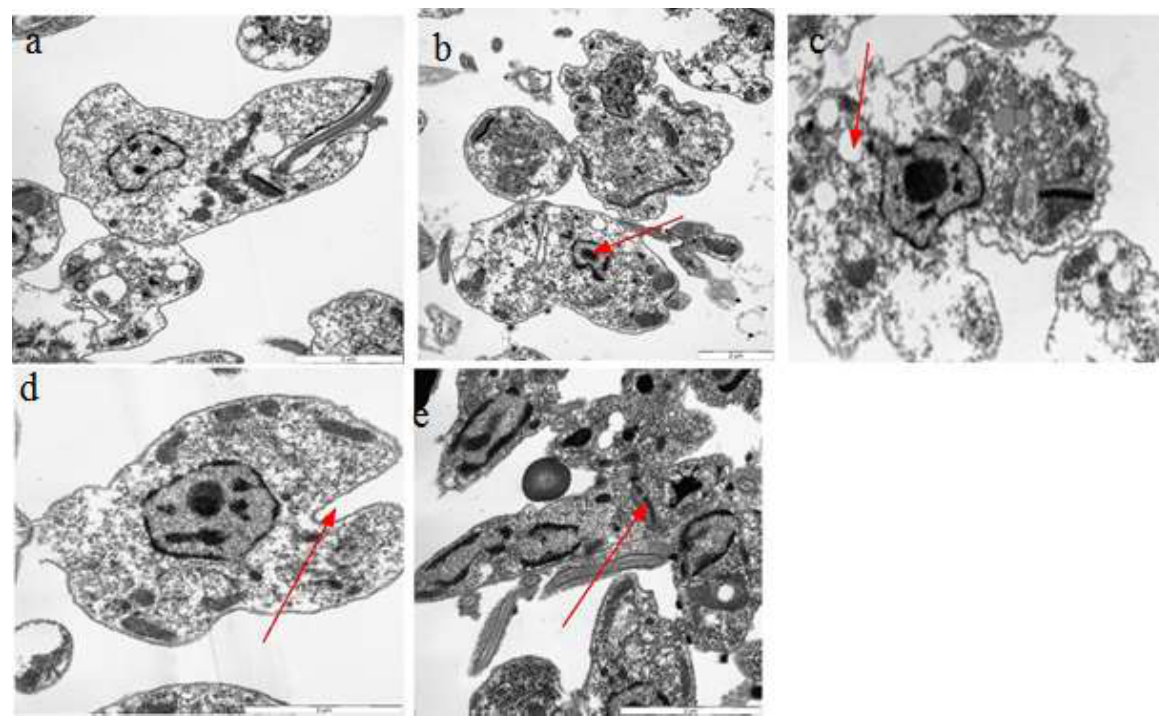
Figure 12. Ultrastructural changes in L. donovani LV82 promastigotes treated with quercetin at 500 µg/mL for 72 h. ( a ) Normal cells, ( b ) nuclear condensation, ( c ) appearance of lipid reservoirs, ( d ) distortion of the flagellar pocket, and ( e ) disruption of the mitochondria–kinetoplast complex.